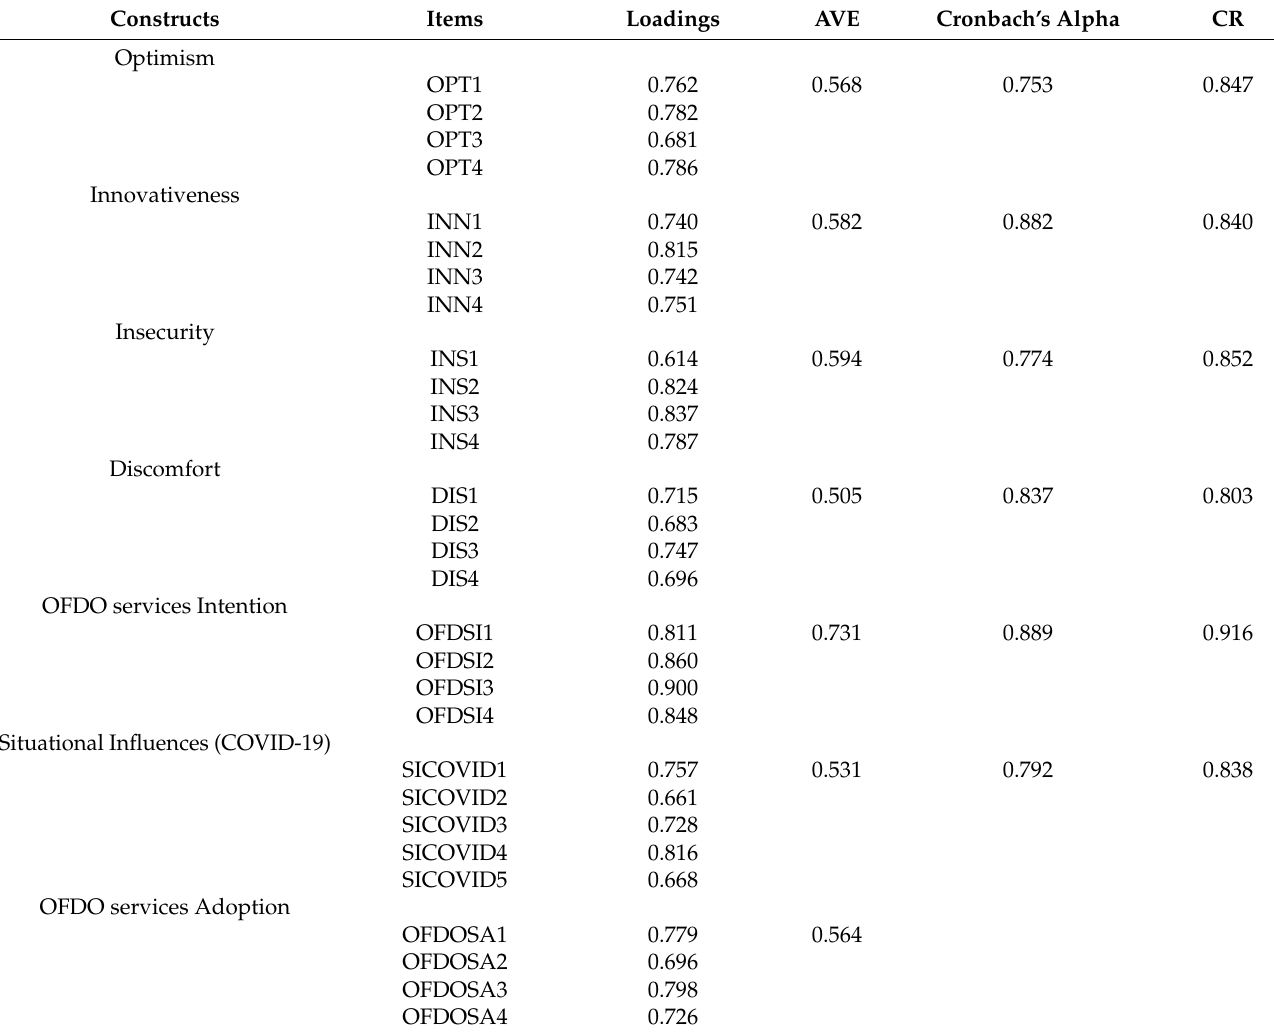
Table 2. Measurement